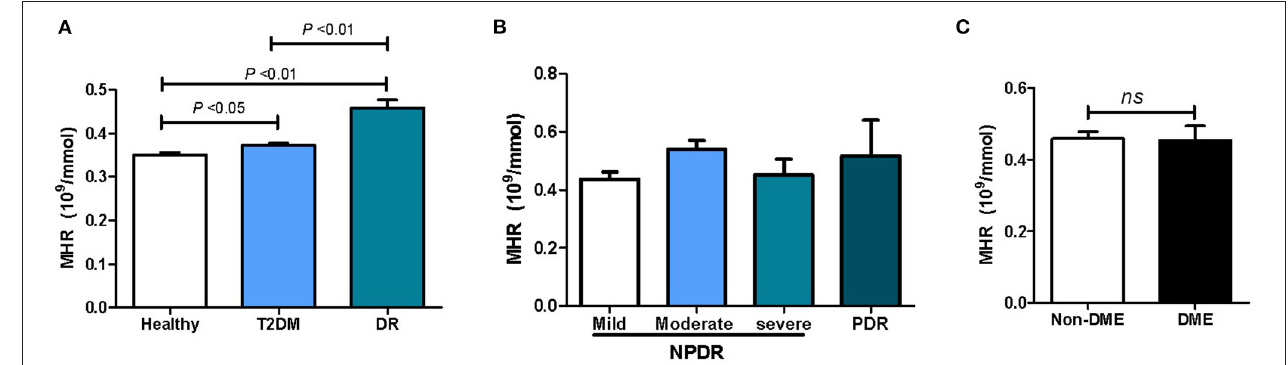
FIGURE 1 | The association between the MHR and patients with DR. (A) MHR levels in healthy controls, diabetic patients with and without DR; (B) MHR levels in DR subjects with different severity; (C) MHR levels between subjects with DME and non-DME.